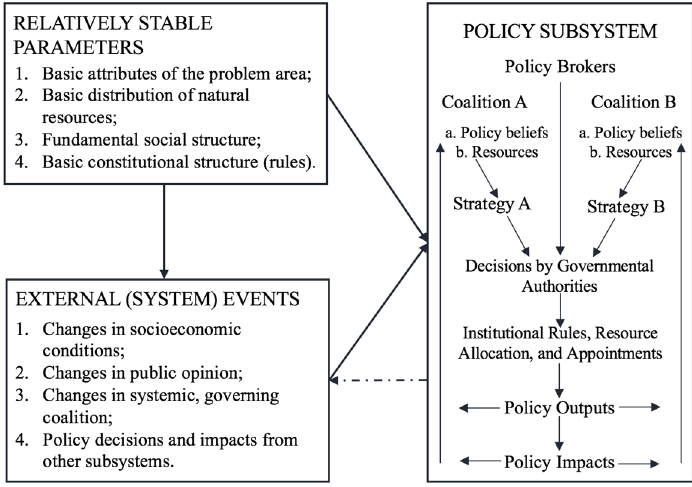
Figure 1. The Advocacy Coalition Framework, revised according to Weible et al. [39].